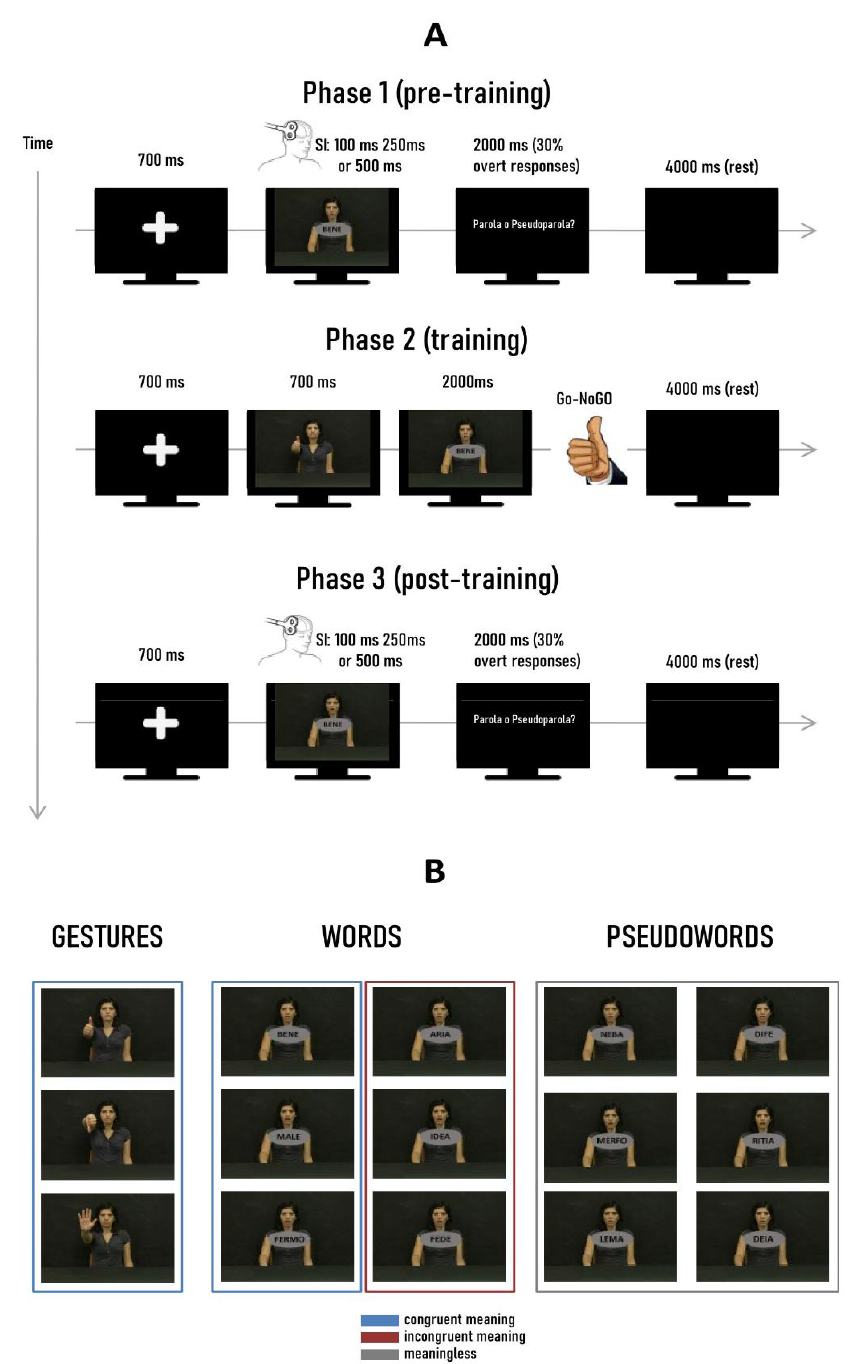
Figure 1. ( A ) Experimental paradigm: the experiment was divided into three phases: (1) pre-learning, (2) learning, and (3) post-learning. Pre-learning and post-learning procedures were identical. Participants observed a fixation crossed and had to make a lexical decision task in response to a verbal stimulus presentation (word or pseudoword). No gestural stimuli were presented in this phase. In the training phase (2), participants observed a gesture as a prime stimulus, followed by a meaningful verbal stimulus (congruent or incongruent with the gesture). Then, they had to perform the observed gesture (Go condition). Pseudowords were presented randomly as a No-Go condition that no required gesture execution. ( B ) Gestural and verbal stimuli presented in the experiment. Colored frames indicate the semantic relation of each class of verbal stimuli with gestures (congruent, incongruent, or meaningless).